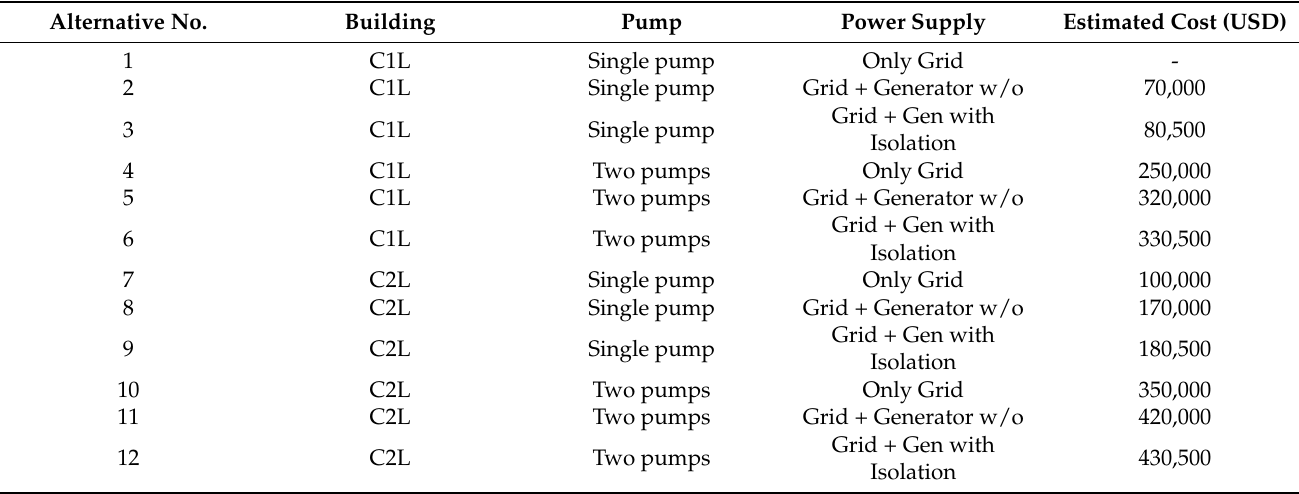
Table 1. Alternative mitigation